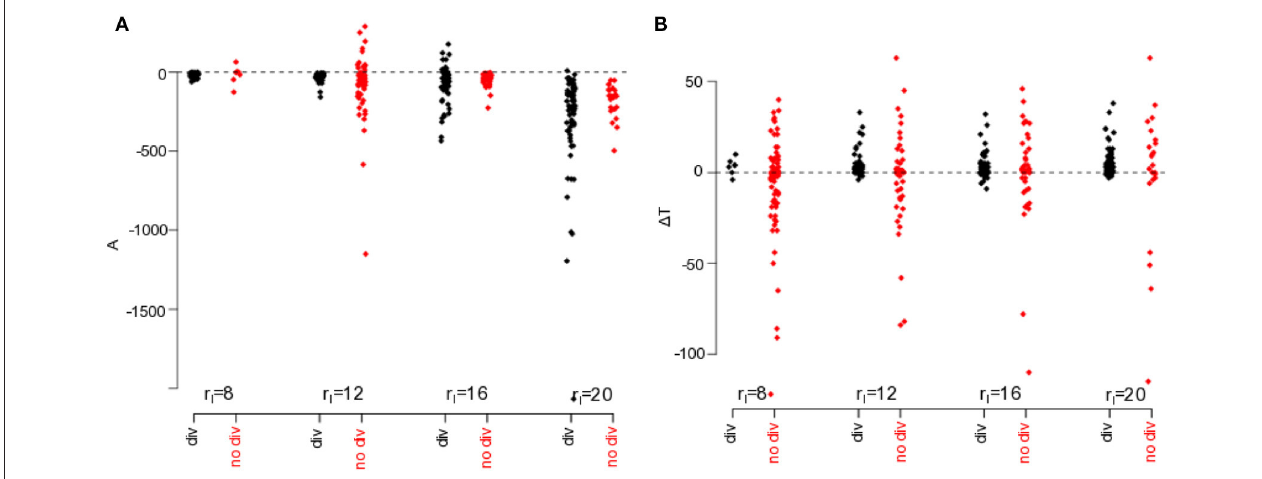
A o A u is the difference between = − T o T u is the difference of times when the weighted = − =